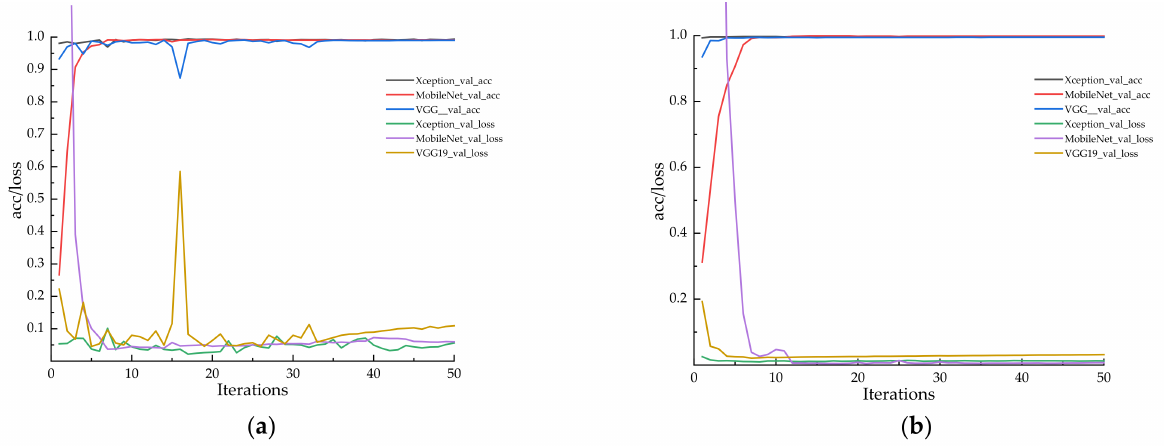
Figure 10. The training results of the VGG19, Xception, and MobilenetV2 models. Results of the feeding validation dataset ( a ); results of the drinking validation dataset ( b ).